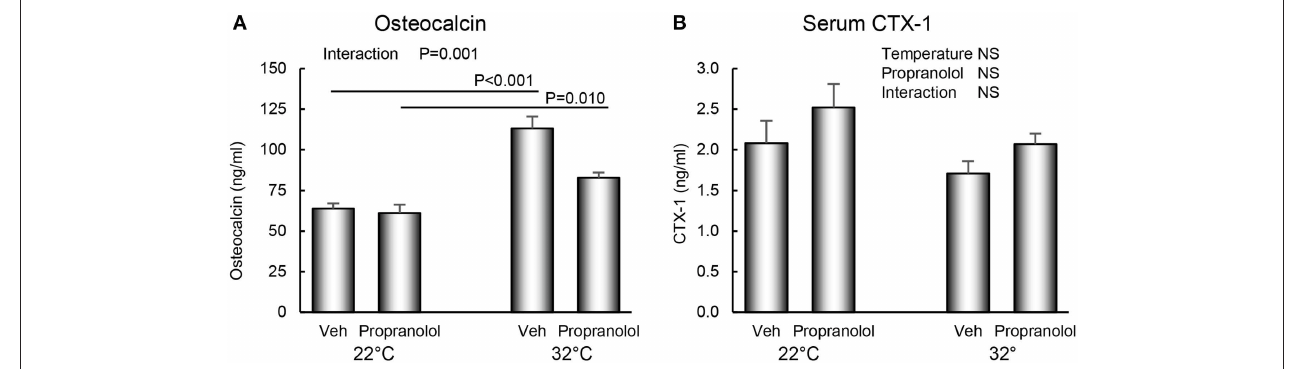
FIGURE 5 | Effect of housing temperature (temperature) and treatment with propranolol (treatment) on (A) serum osteocalcin, a marker of global bone formation and (B) serum CTX-1, a marker of global bone resorption. Data are mean ± SE. N = 10/group. Post-hoc analysis was performed when there was a significant interaction